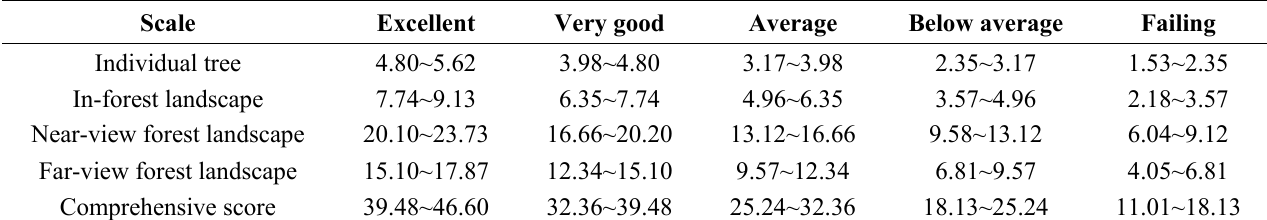
Table 7. Score range of the quality levels of scenic